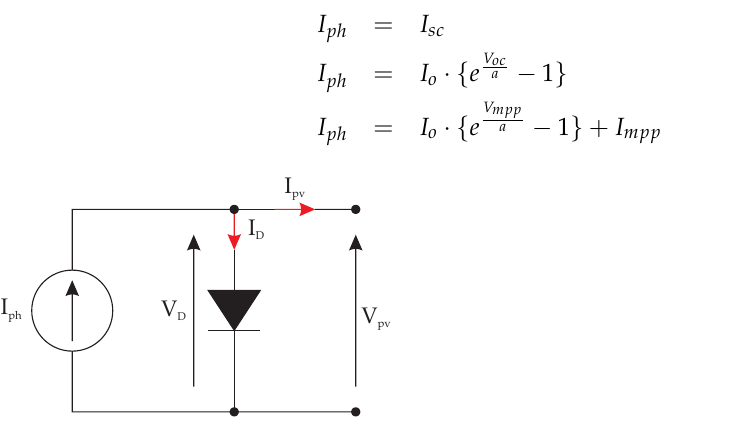
Figure 1. Ideal solar PV